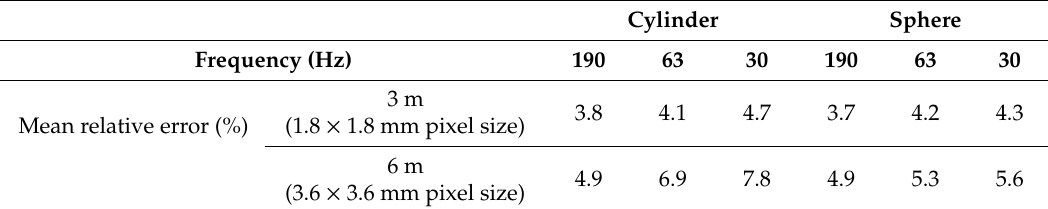
Table 1. Comparison of measured and detected projected median areas of metal